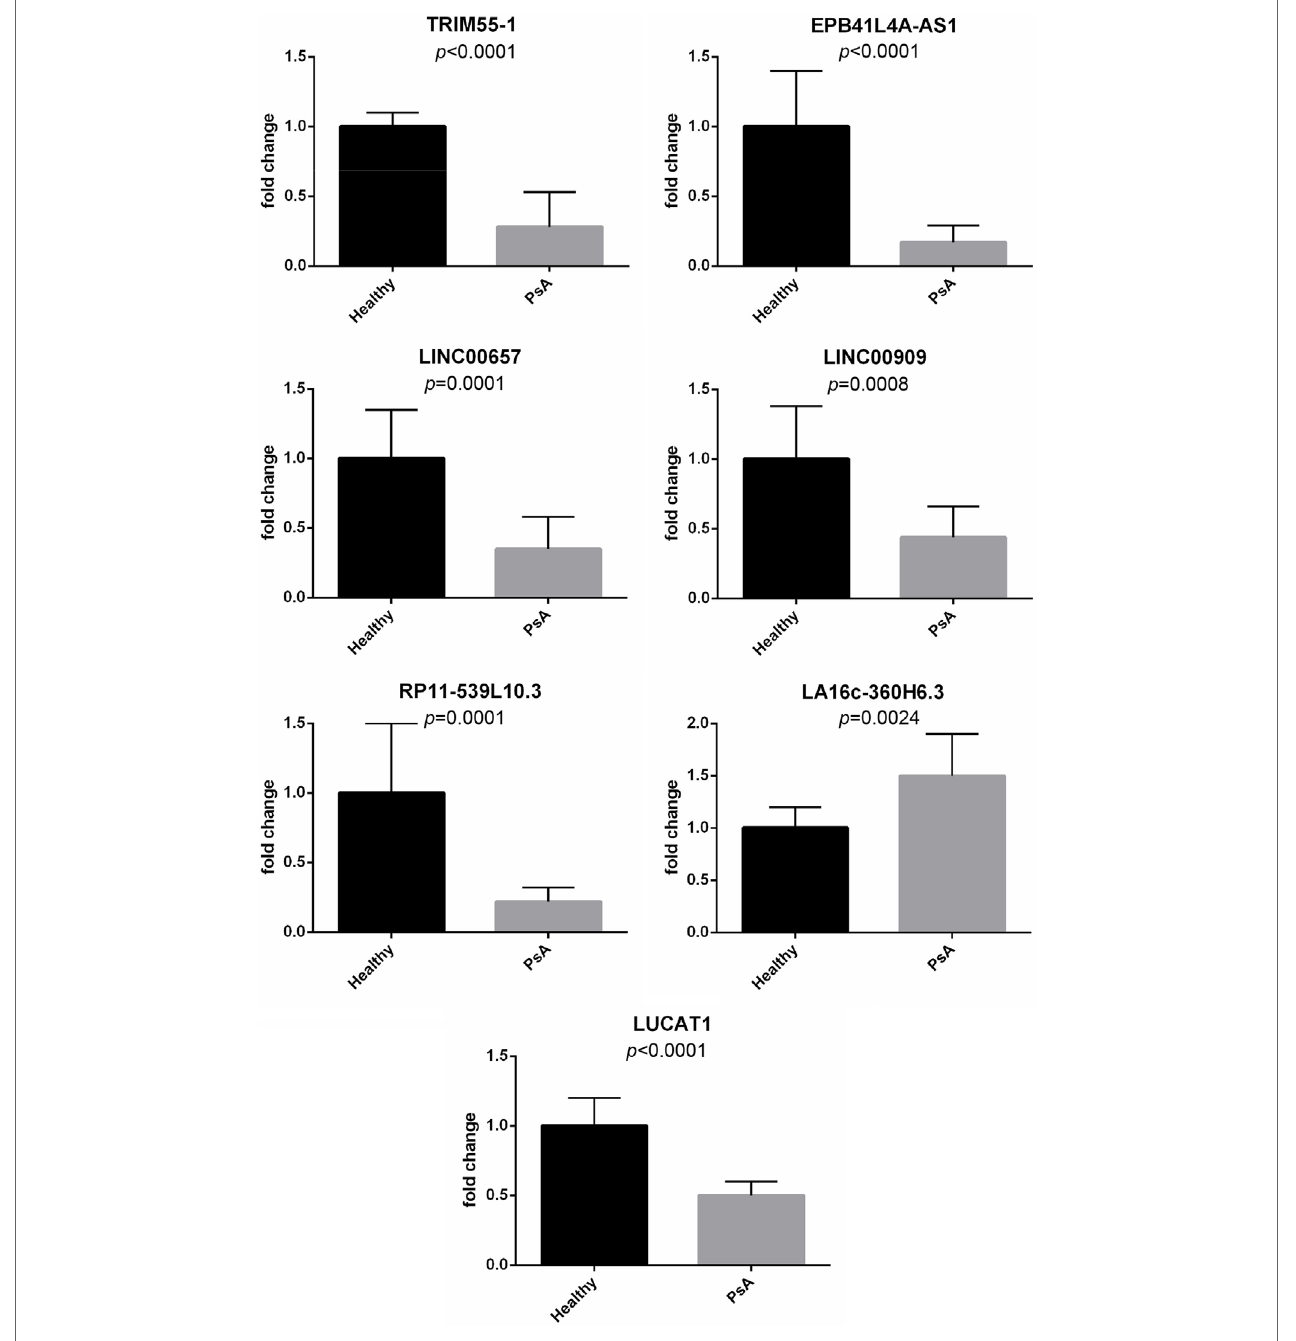
FigUre 1 | Expression of selected long non-coding RNAs in an expanded panel of psoriatic arthritis patients (20 patients) and healthy controls (20 subjects). Bars indicate